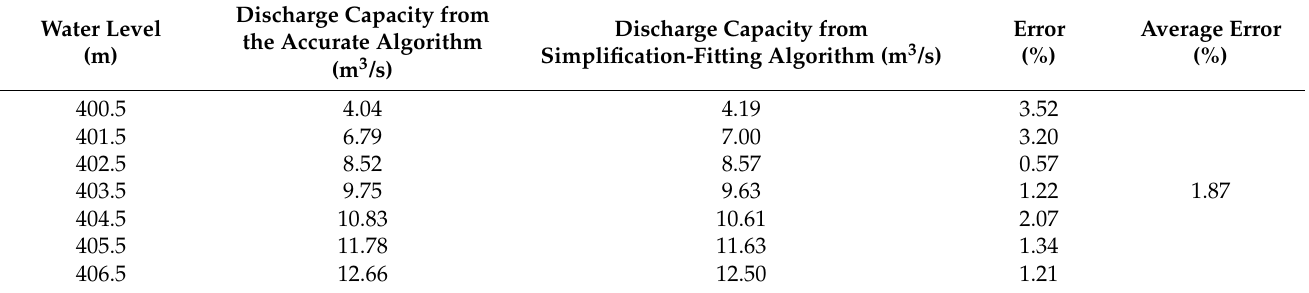
Table 3. Statistical table on errors between the simplified and accurate algorithms in the half-pressure flow stage.